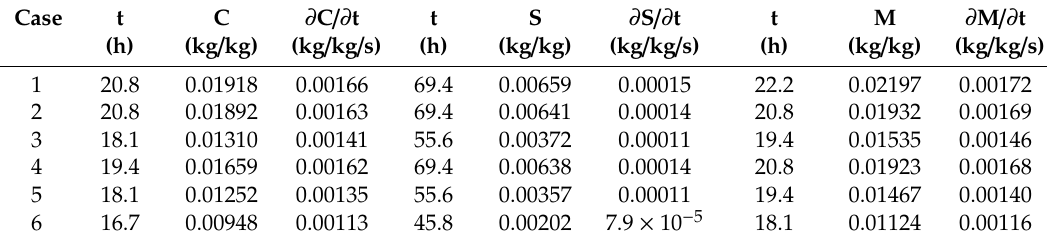
Table 3. Values for the concentrations of C, S, and M, and the maximum absorption value at the center of the